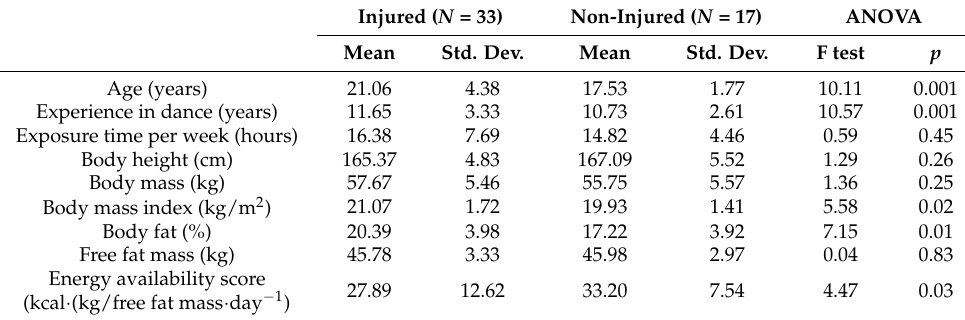
Table 2. Differences between groups based on soft-tissue injury occurrence.